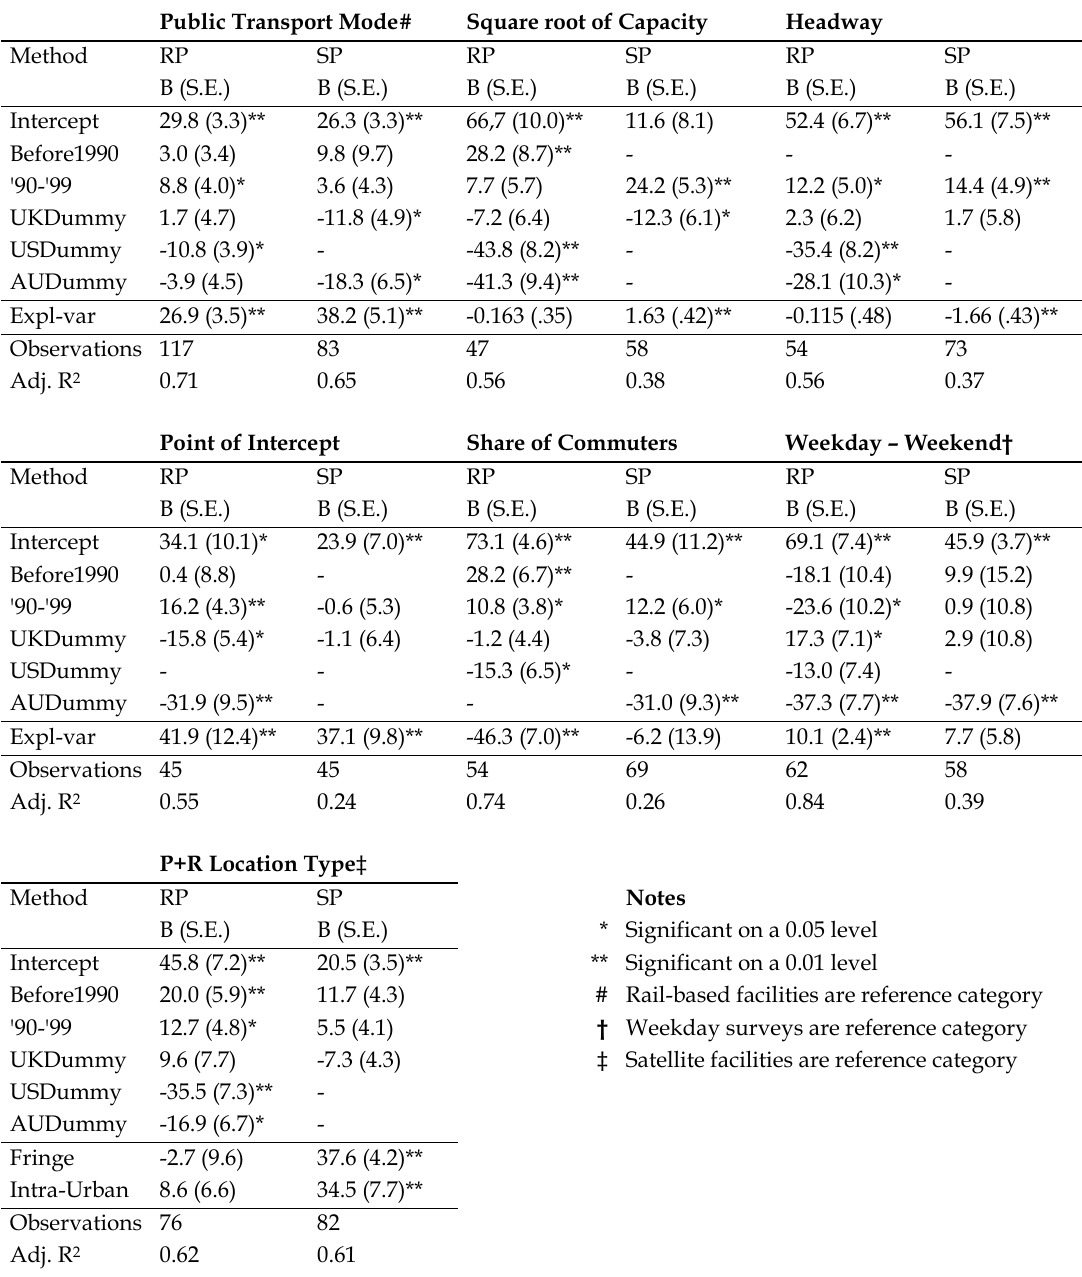
Table 3. Results from the 14 regression